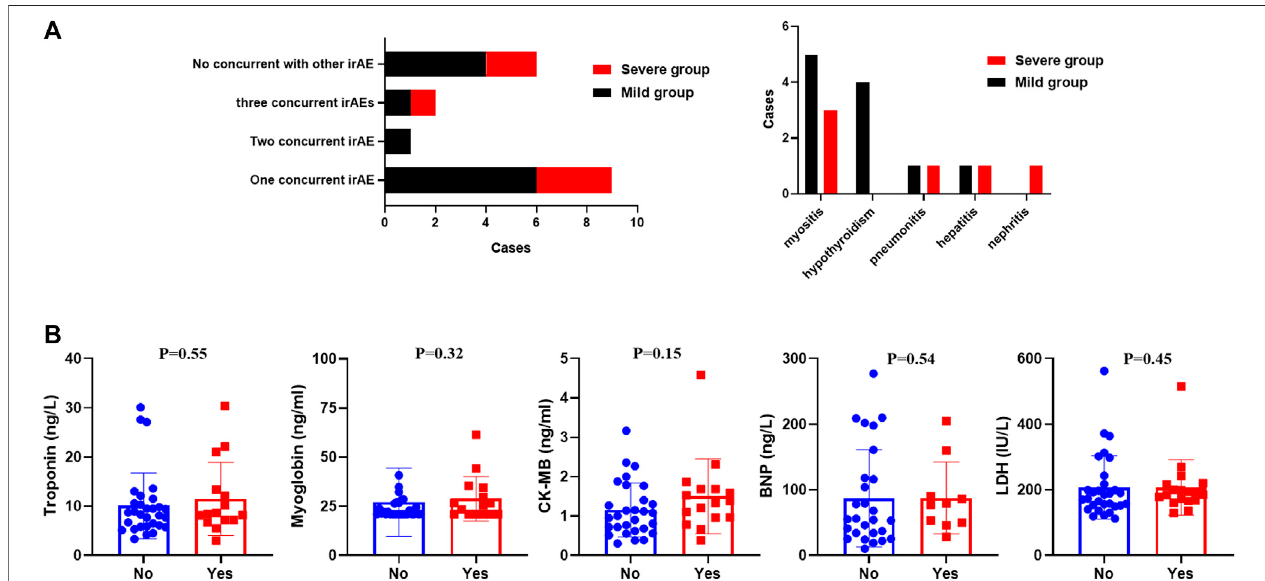
FIGURE 2 | (A) Distribution of concurrent irAEs in our study. (B) Serum myocardial enzymes and LDH between patients with or without immune-related myocarditis.